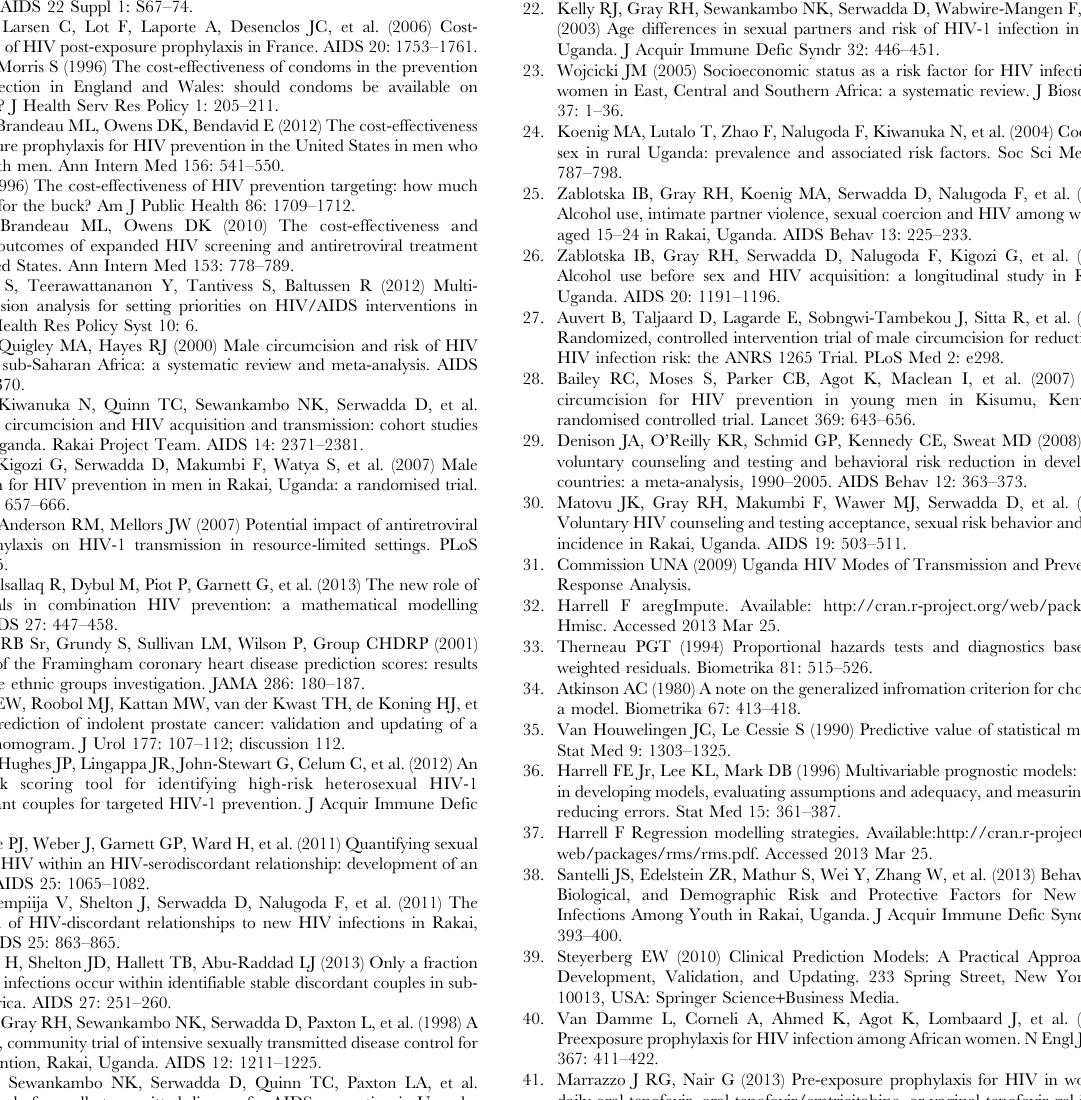
algorithm. AIDS 25: 1065–1082. 17. Gray R, Ssempiija V, Shelton J, Serwadda D, Nalugoda F, et al. (2011) The contribution of HIV-discordant relationships to new HIV infections in